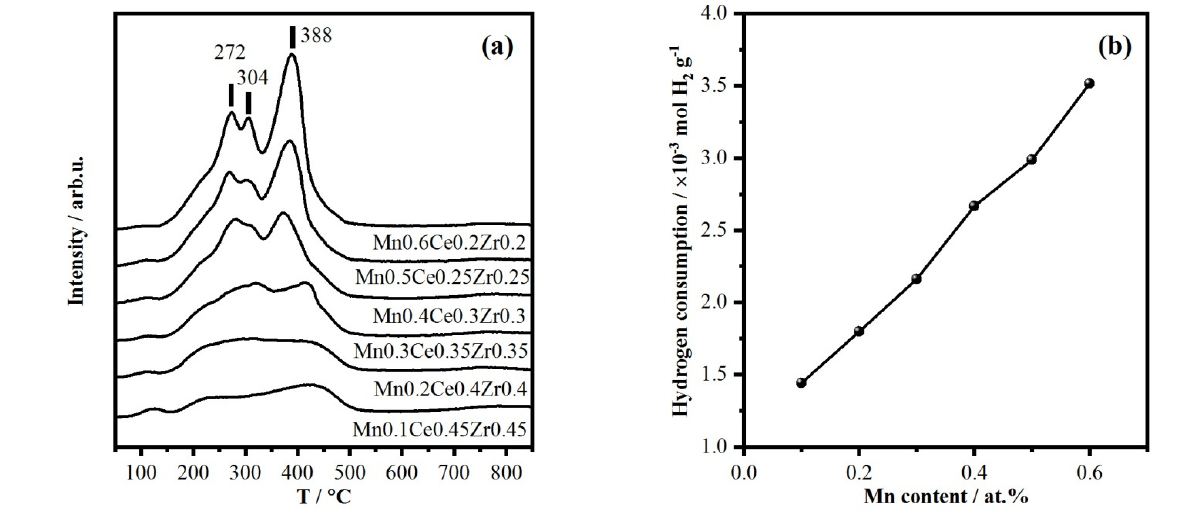
Figure 7. TPR curves ( a ) and total amount of hydrogen consumed per g ( b ) of Mn(x)Zr(0.5 − x/2)Ce(0.5 − x/2) catalysts. Table 4. Atomic ratios of the elements on the surface according to XPS results.